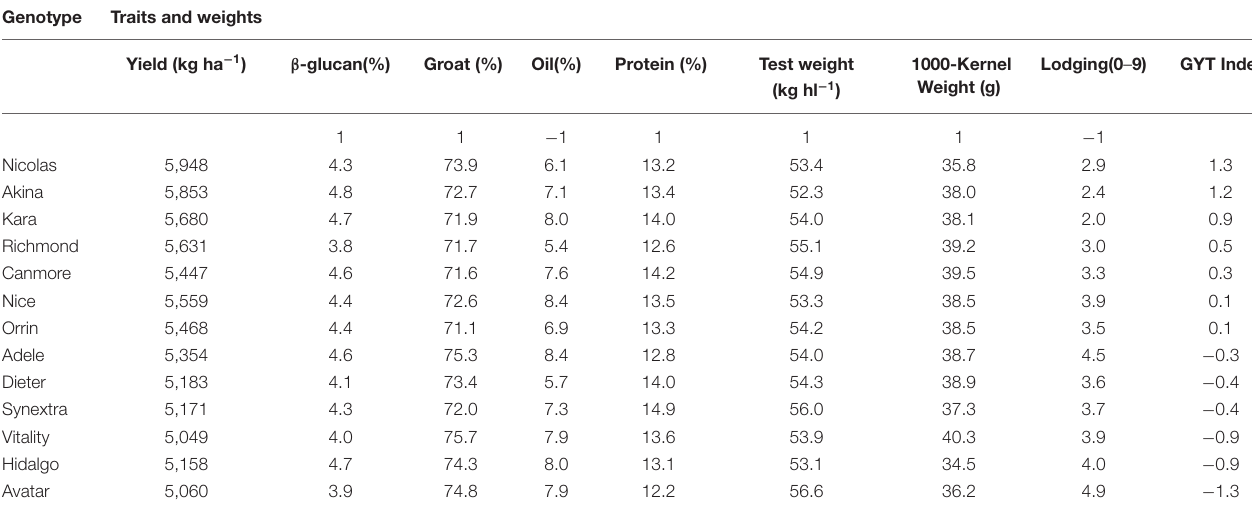
TABLE 4 | Mean trait values of 13 oat cultivars tested in the 2013–2019 Quebec provincial oat trials and their GYT (Genotype by Yield * Trait) index. Genotype Traits and weights